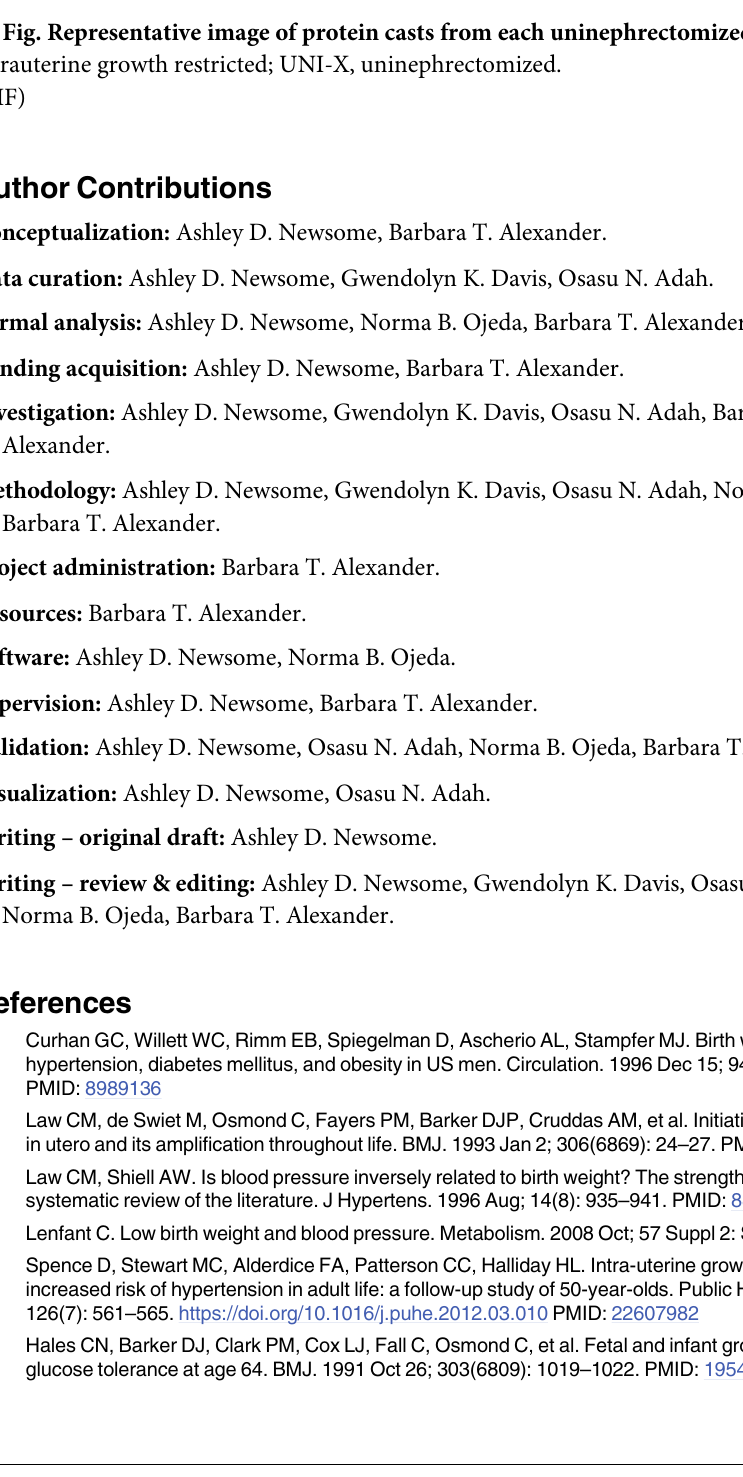
S2 Fig. Representative image of glomeruli from each uninephrectomized group. IUGR, intrauterine growth restricted; UNI-X, uninephrectomized. (TIF) S3 Fig. Representative image of interstitial fibrosis from each uninephrectomized group. IUGR, intrauterine growth restricted; UNI-X, uninephrectomized. (TIF) S4 Fig. Representative image of protein casts from each uninephrectomized group. IUGR, intrauterine growth restricted; UNI-X, uninephrectomized.